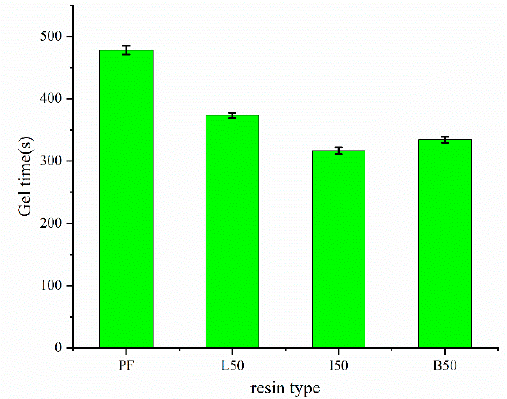
Figure 9. Gel time of PF, ALPF (L50), and DLPF (I50, B50) resins with 50% lignin substitution.